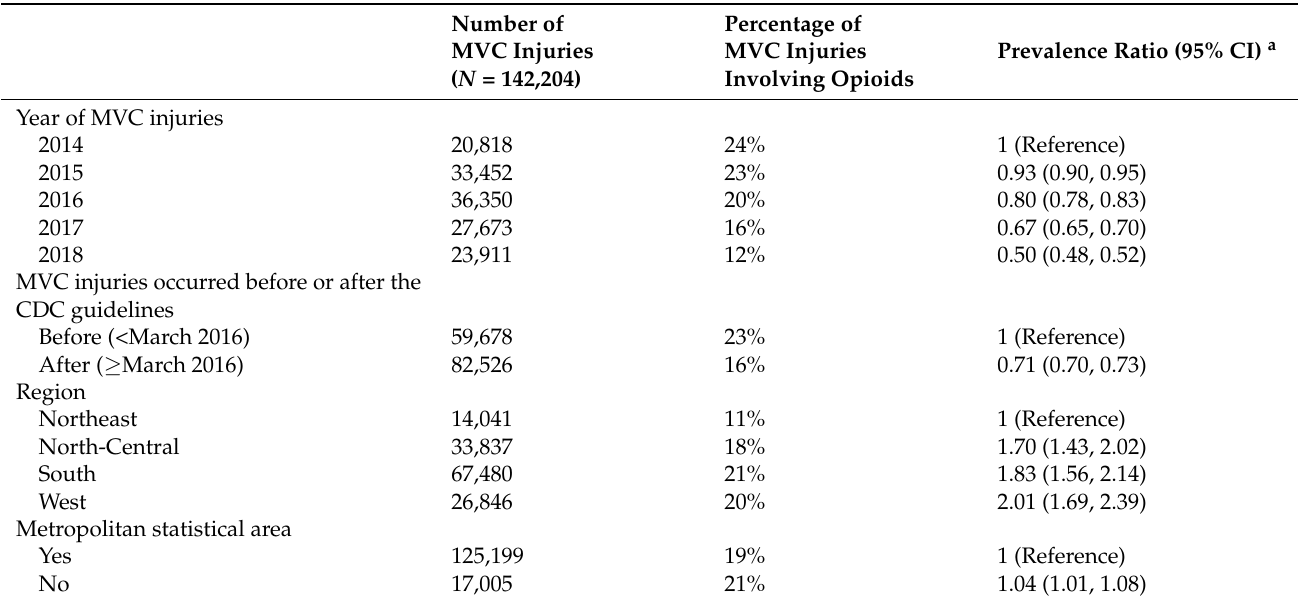
Table 1. Prevalence and prevalence ratios for prescription opioids in motor vehicle crash (MVC) injuries, US, 2014–2018.